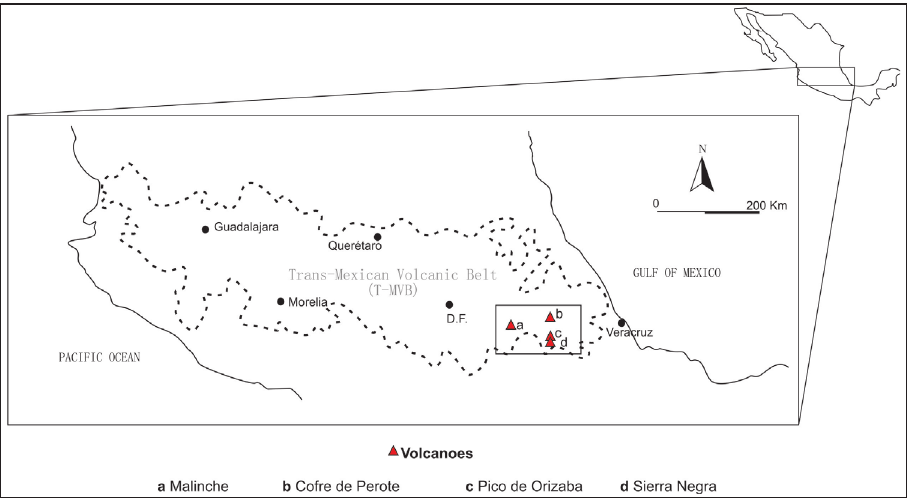
Figure 1. Sampled mountains are in the Eastern part of the Trans-Mexican Volcanic Belt: Malinche, Cofre de Perote, Pico de Orizaba and Sierra